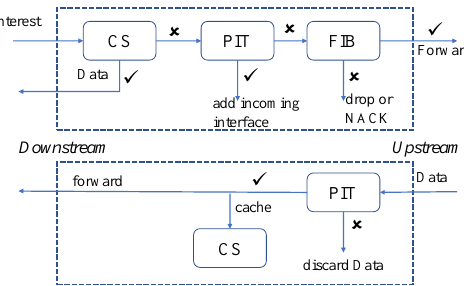
Figure 12. Data-forwarding process in NDN